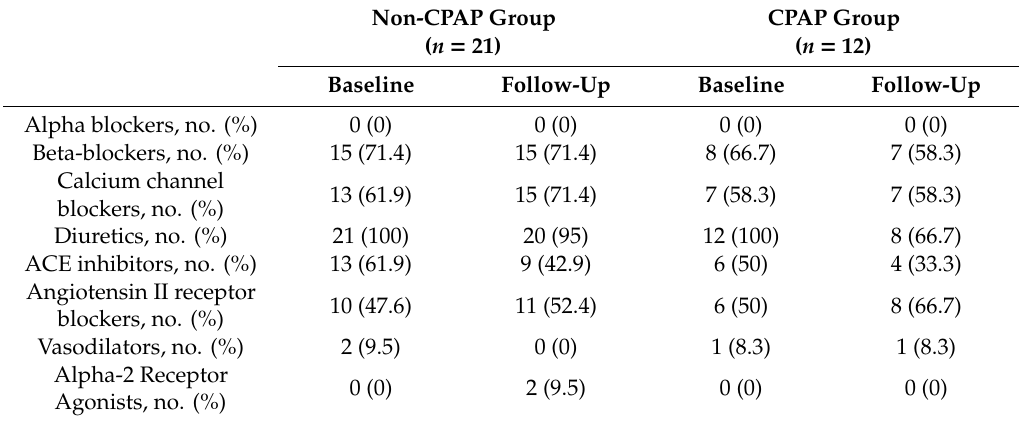
Table 3. Antihypertensive medication usage between initial and follow-up